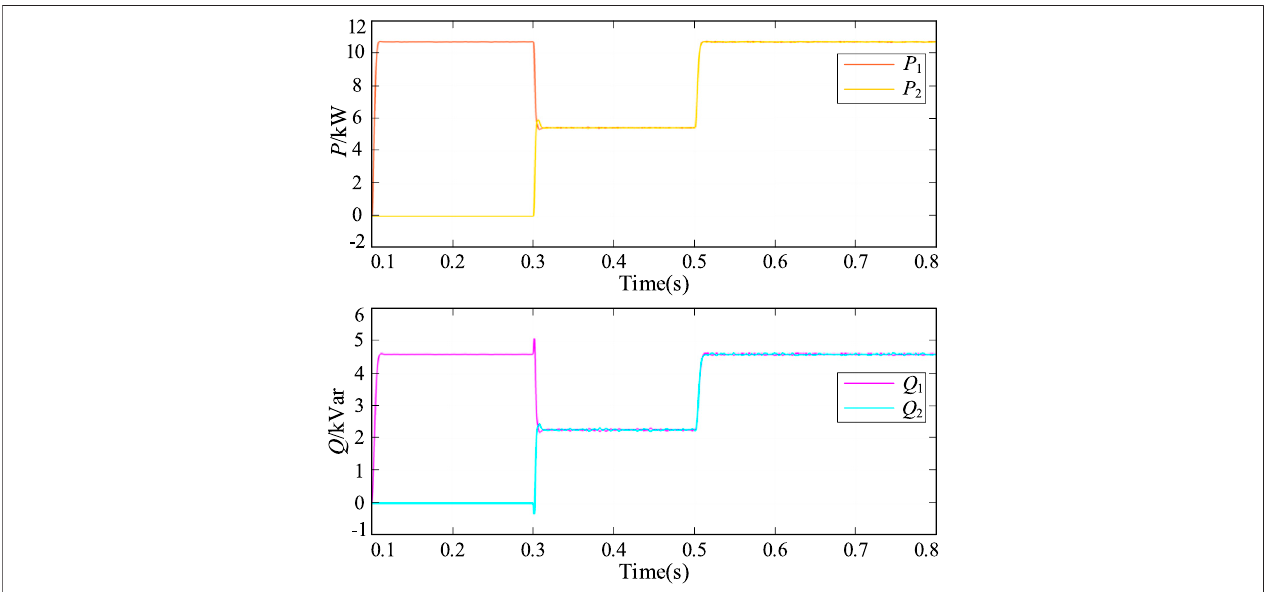
FIGURE 15 | Active and reactive power output of the inverter. Line impedance is the same.